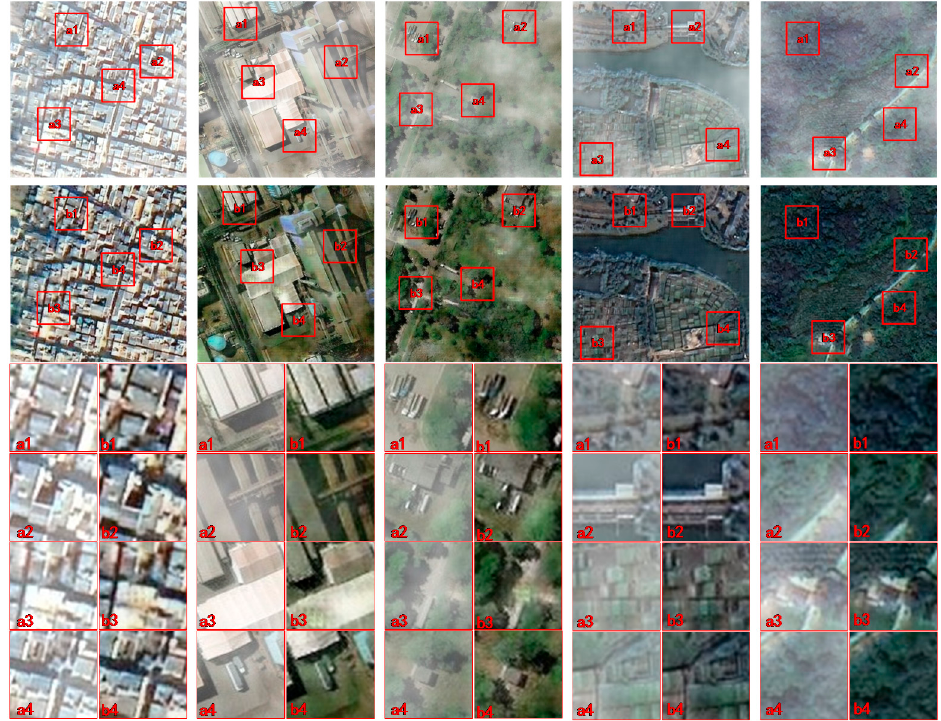
Figure 6. Results of dehazed remote-sensing image in five scenarios. For a more detailed comparison, four patches are zoomed out from each picture. These patches are marked as a n or b n { n = 1, 2, 3, 4}, where a refers to hazy remote-sensing images and b refers to dehazed remote-sensing images.